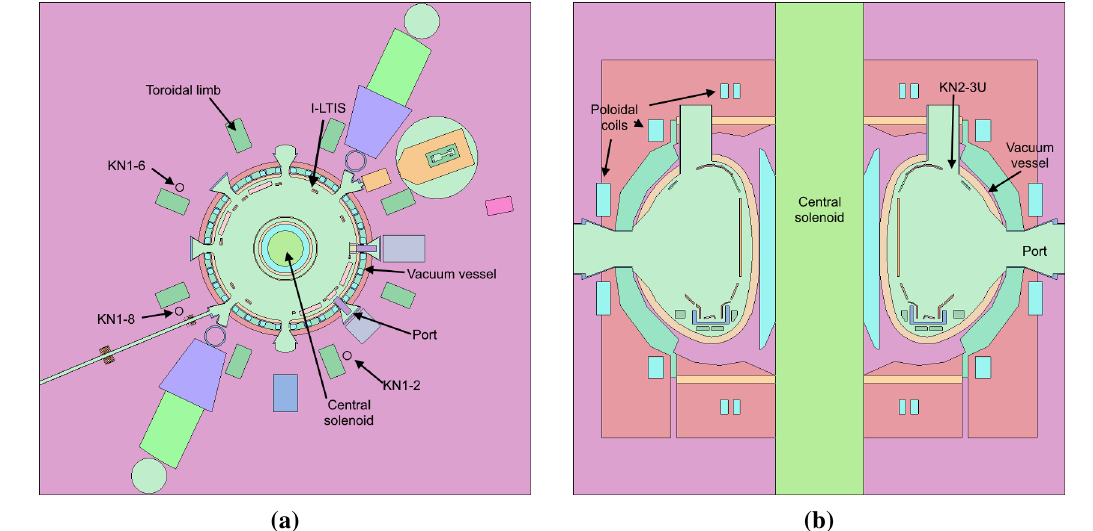
Figure 1: Cross sectional view of the JET tokamak model. The horizontal section is presented in (a) and the vertical section is presented in